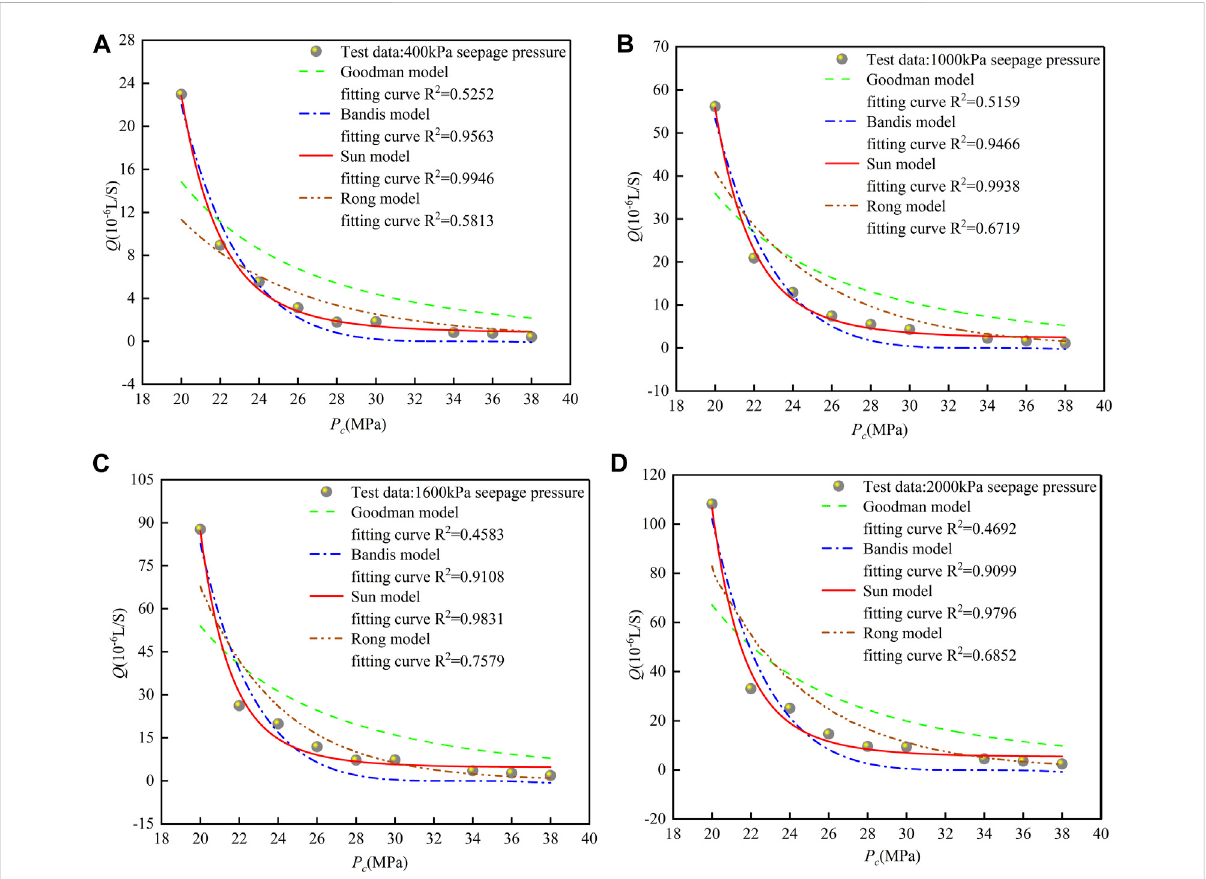
FIGURE 5 Variations in the fl ow rate ( Q ) with the con fi ning pressure ( P c ). (A) P s = 400 kPa, (B) P s = 1,000 kPa, (C) P s = 1,600 kPa, and (D) P s = 2,000 kPa. The solid line is the fi tting curve for the Sun model, the dashed line is the fi tting curve for the Goodman model, the dotted-dashed line is the fi tting curvefortheBandismodel,andthedashed-dotted-dottedlineisthe fi ttingcurvefortheRongmodel.Thediscretesymbolsaremeasurementpoints from the hydromechanical tests with different fl ow